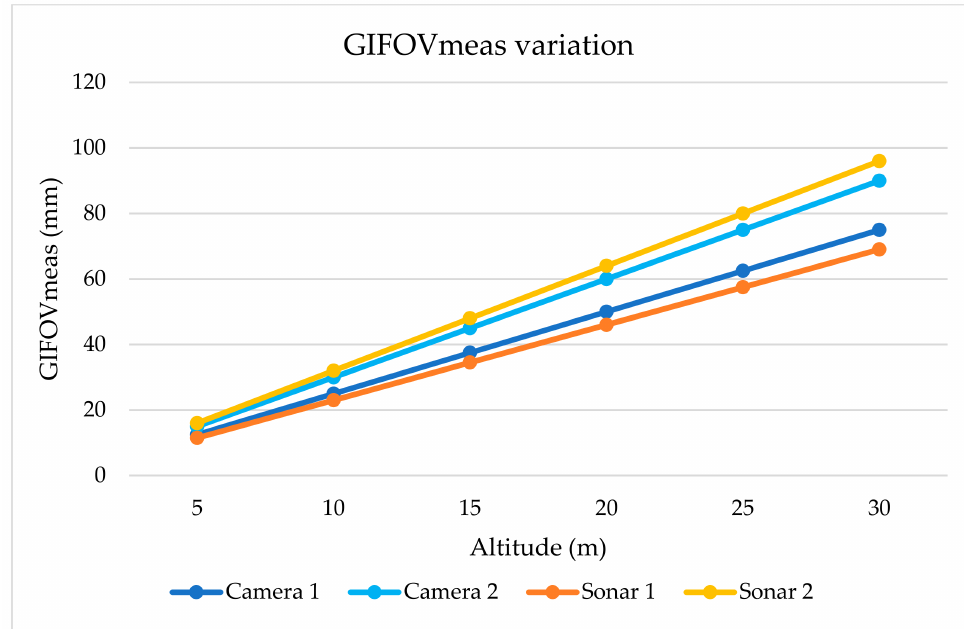
Figure 8. Ground instantaneous FOV (GIFOV) variation in different cameras and sensors. Once the GIFOVmeas is defined, it is possible to analyse the influence of the camera or sensor model in the Zd definition. Using Equation (16) and for the case of camera 1, a Zd value of 20 m is obtained when the operation requires a GIFOVmeas of 45